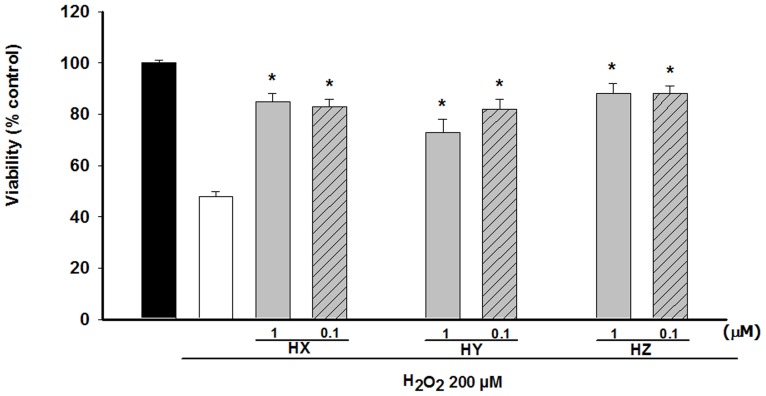
Atenuation of H2O2-induced cell damage by 0.1 µM and 1 µM concentrations of huprines: HX, HY and HZ in NGF differenciated PC12 cells.Cells were incubated with 200 µM H2O2 for 2 h. Compounds were added to the culture 48 h prior to H2O2 addition. Cell viability was assessed by measuring the MTT reduction. At least three independent experiments were carried out in triplicate. The data are means ± s.e.m. expressed as percentage of control value. *P<0.05 compared with H2O2 group (Dunnett's test).